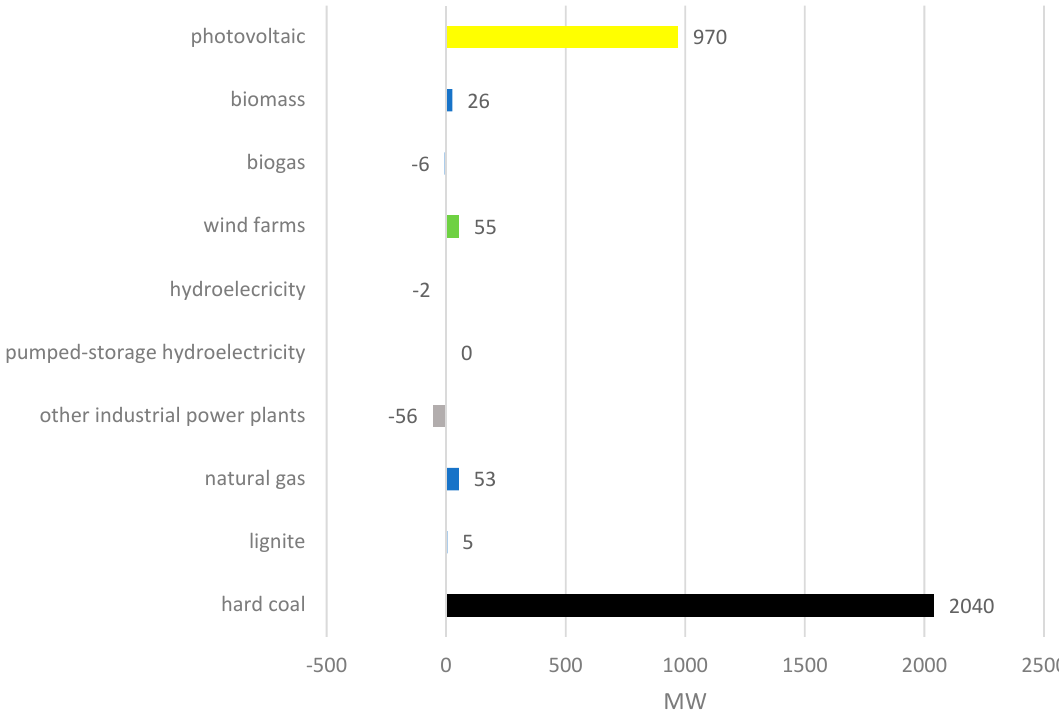
Figure 4. Changes in the installed capacity in 2019 compared to 2018, source: own study based on data [17].